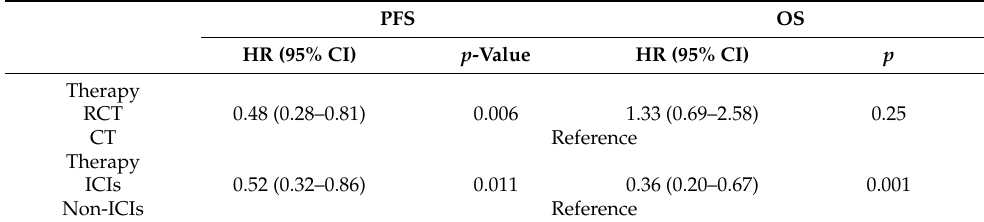
Figure 1. The PFS and OS in the ICIs group and control group. ( a ) The PFS in the ICIs group and control group. ( b ) The OS in the ICIs group and control group. Table 2. Prognostic factors by multivariate analysis.